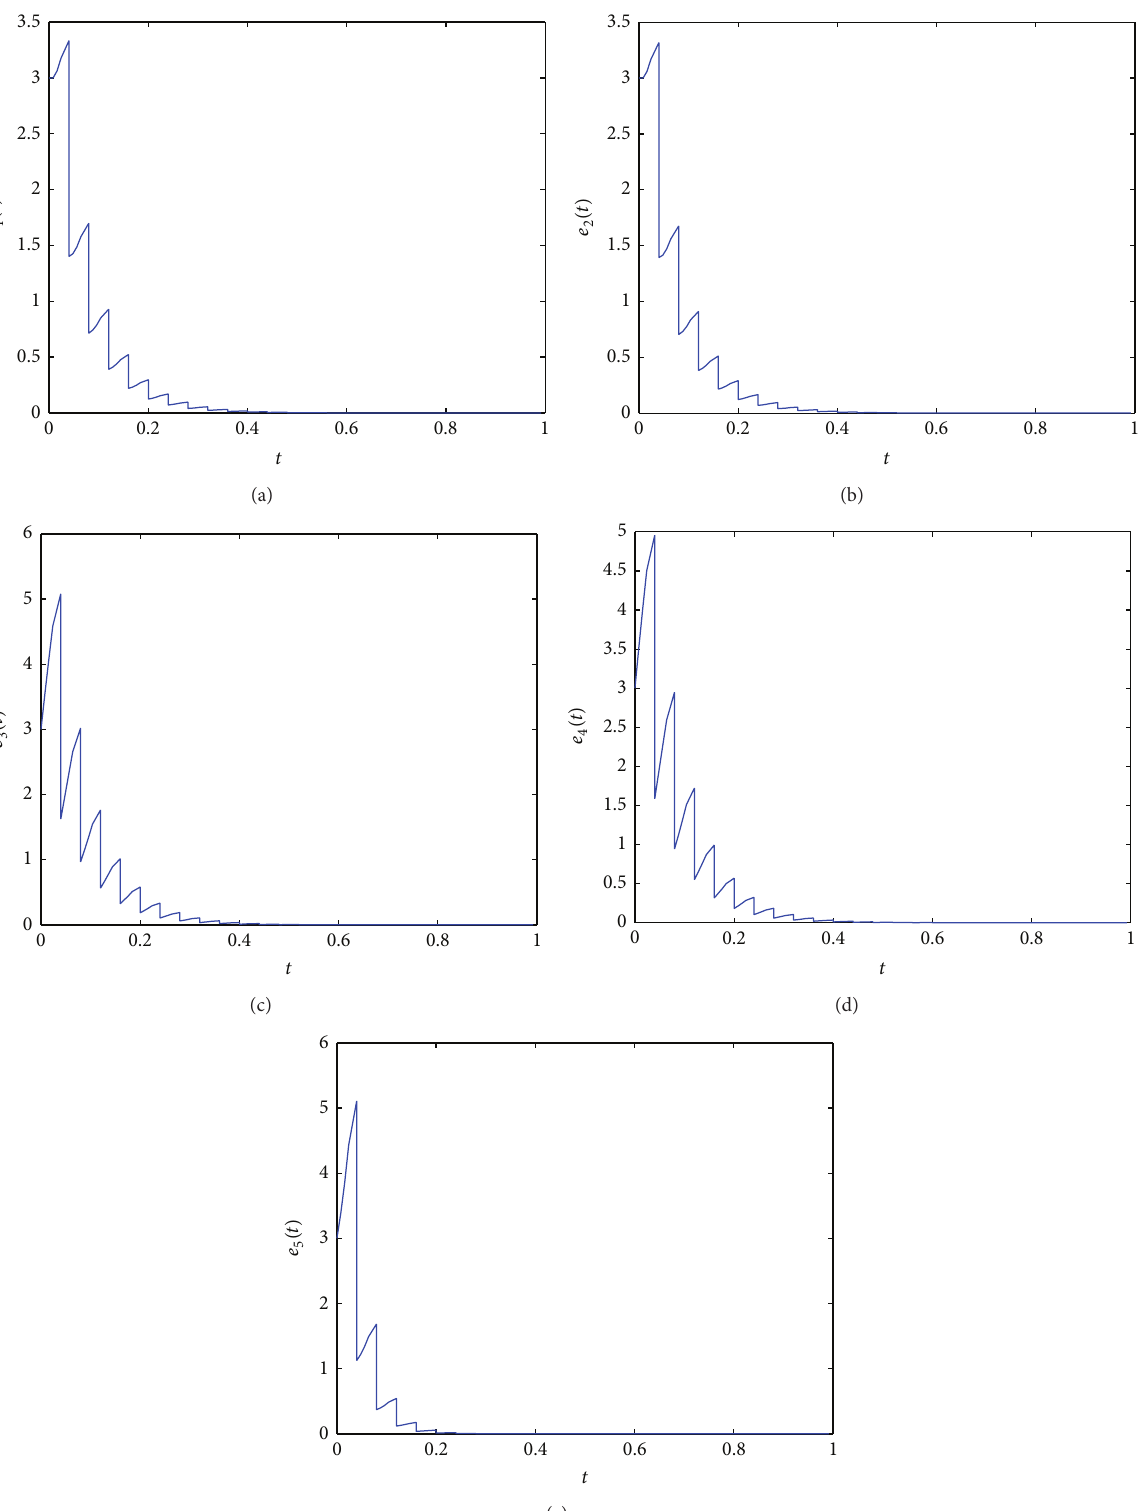
Figure 3: Synchronization errors solutions of system (20) with 𝜏 = 0.01